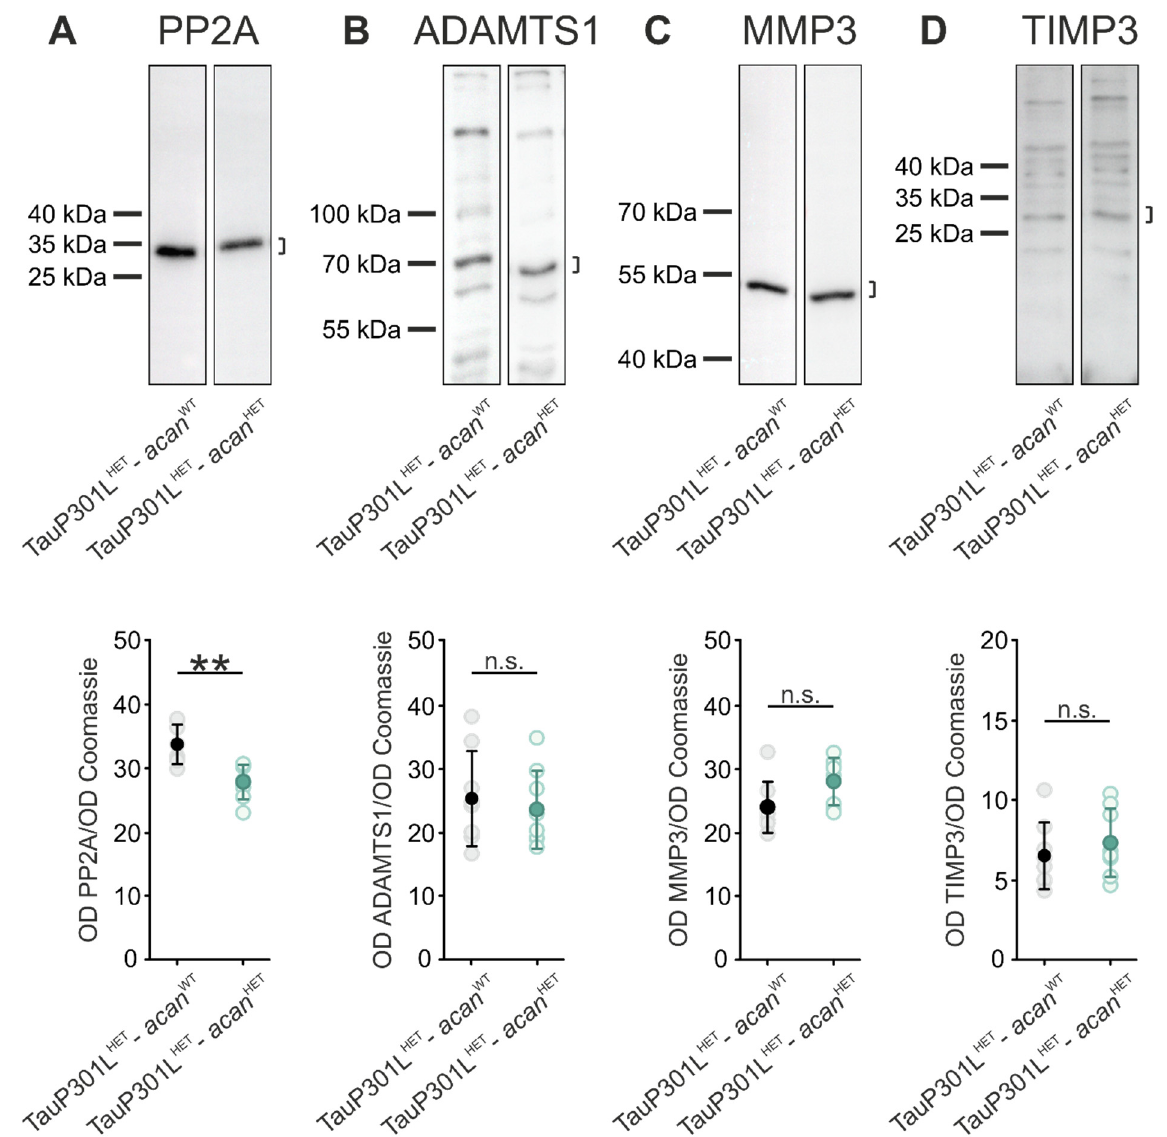
Figure 5. Protein level of PN modulating enzymes in the brainstem of TauP301- acan mice. ( A ) Western blot analysis of the amount of PP2A (clone E155 (Abcam), at ~35 kDa) in the brainstem with a significant decrease in TauP301L HET - acan HET mice compared to TauP301L HET - acan WT mice ( p = 0.001, n = 8, t -test). ( B – D ) Western blot analysis of ADAMTS1 (B, AF5867 (R&D Systems), at ~70 kDA), MMP3 (C, clone EP1186Y (Abcam), at ~50 kDA) and TIMP3 (D, anti-TIMP3 (Proteintech), binds C-terminal, at ~30 kDa) in the brainstem of TauP301L HET - acan HET and TauP301L HET - acan WT mice did not reveal any genotype-specific difference (ADAMTS1: p = 0.620; MMP3: p = 0.055; TIMP3: p = 0.455, TauP301L HET - acan WT n = 8, TauP301L HET - acan HET n = 8, t -test). For Western blot analysis protein extracts from homogenized brainstems of 8 TauP301L HET - acan WT and 8 TauP301L HET - acan HET mice were used. Optical density (OD) of the specific chemoluminescence signal was quantified in relation to Coomassie stained total protein bands. Quantified areas on the Western blot lanes were marked by a bracket. For illustration of exemplary blot lanes, brightness and contrast were adapted. Data are given as mean ± SD, ** p < 0.01, n.s. not